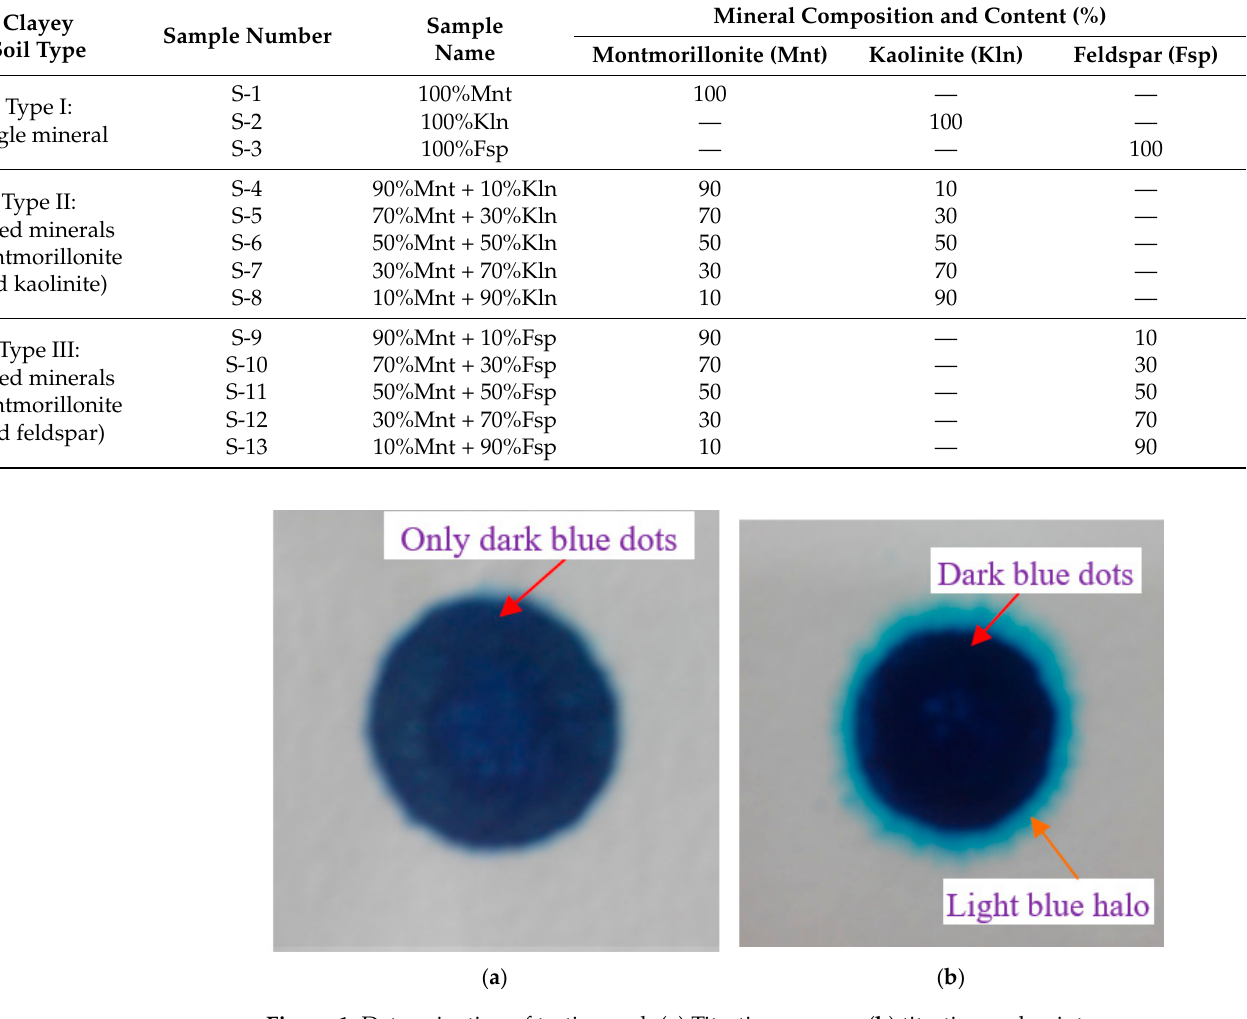
In equation: SSA is specific surface area (m 2 /g); C MB is methylene blue concentration (g/mL); V is the volume of methylene blue solution adsorbed (mL); N A is the Avogadro constant, which equals to 6.02 × 10 23 mol − 1 ; A MB is the area covered by one MB molecule, which equals 130 Å 2 ; m s is the quality of dried soil sample; 319.87 is the molar mass of the MB